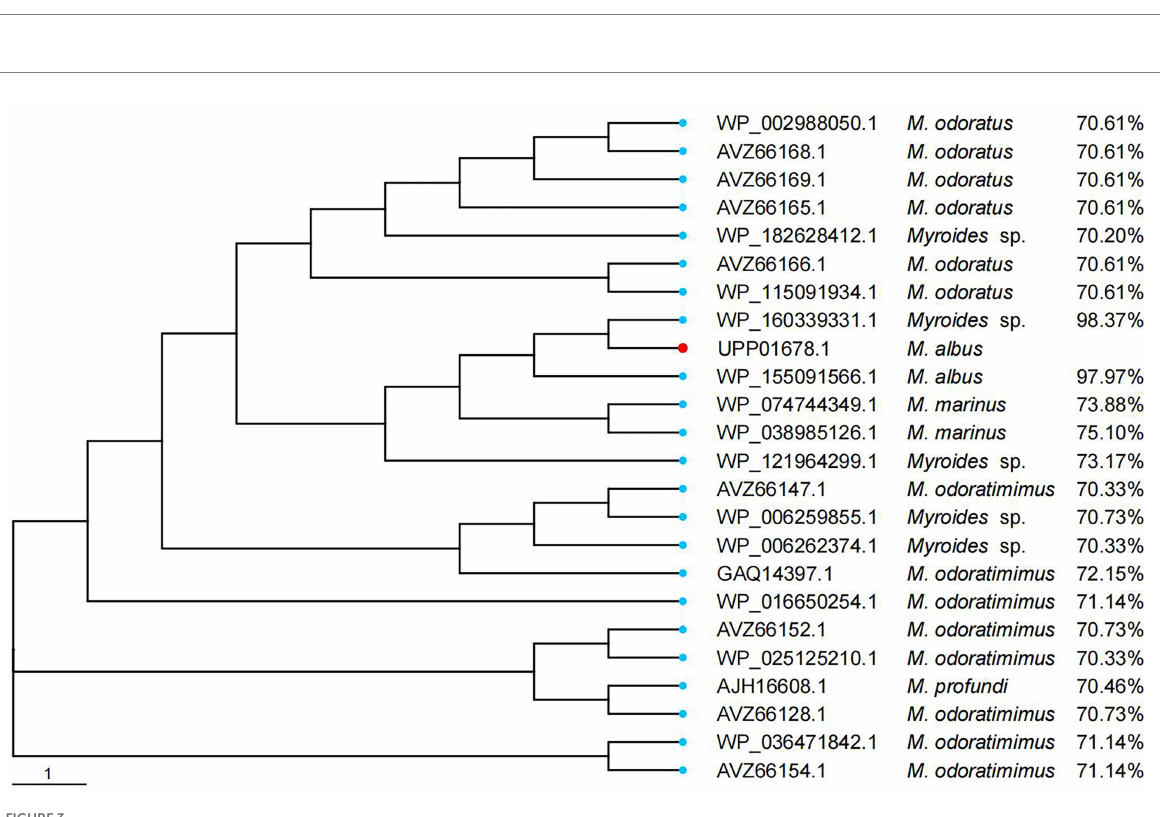
FIGURE 3 Phylogenetic analysis of WUS-1 with other putative class B β -lactamases ( ≥ 70% amino acid similarity). WUS-1 from this study is represented with a red